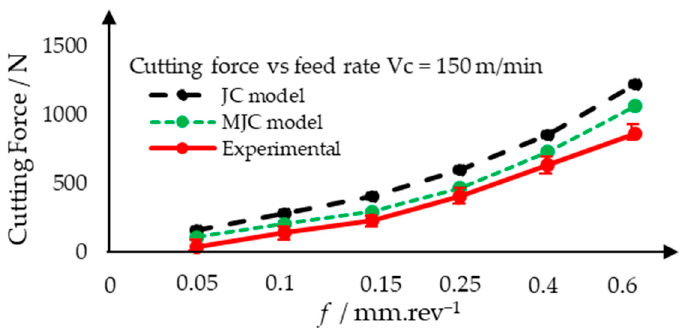
Figure 8. Cutting force predicted by the JC model and modified the JC model for a constant cutting speed of 150 m/min and rake angle of 10°.